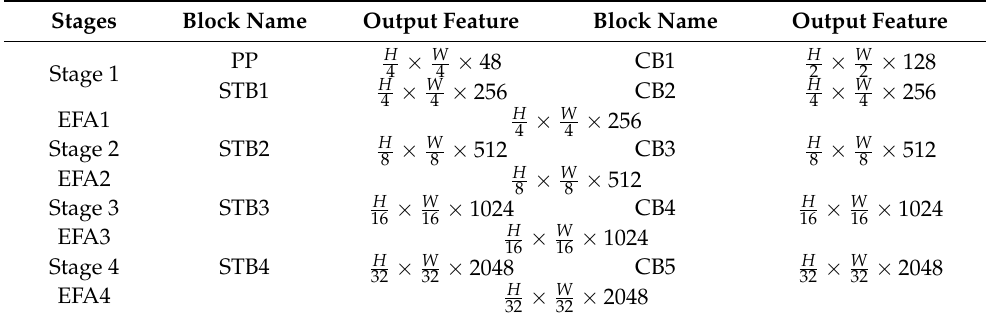
Table A1. Supplementary Details of ICTNet. The size and dimension of output with regard to the block are